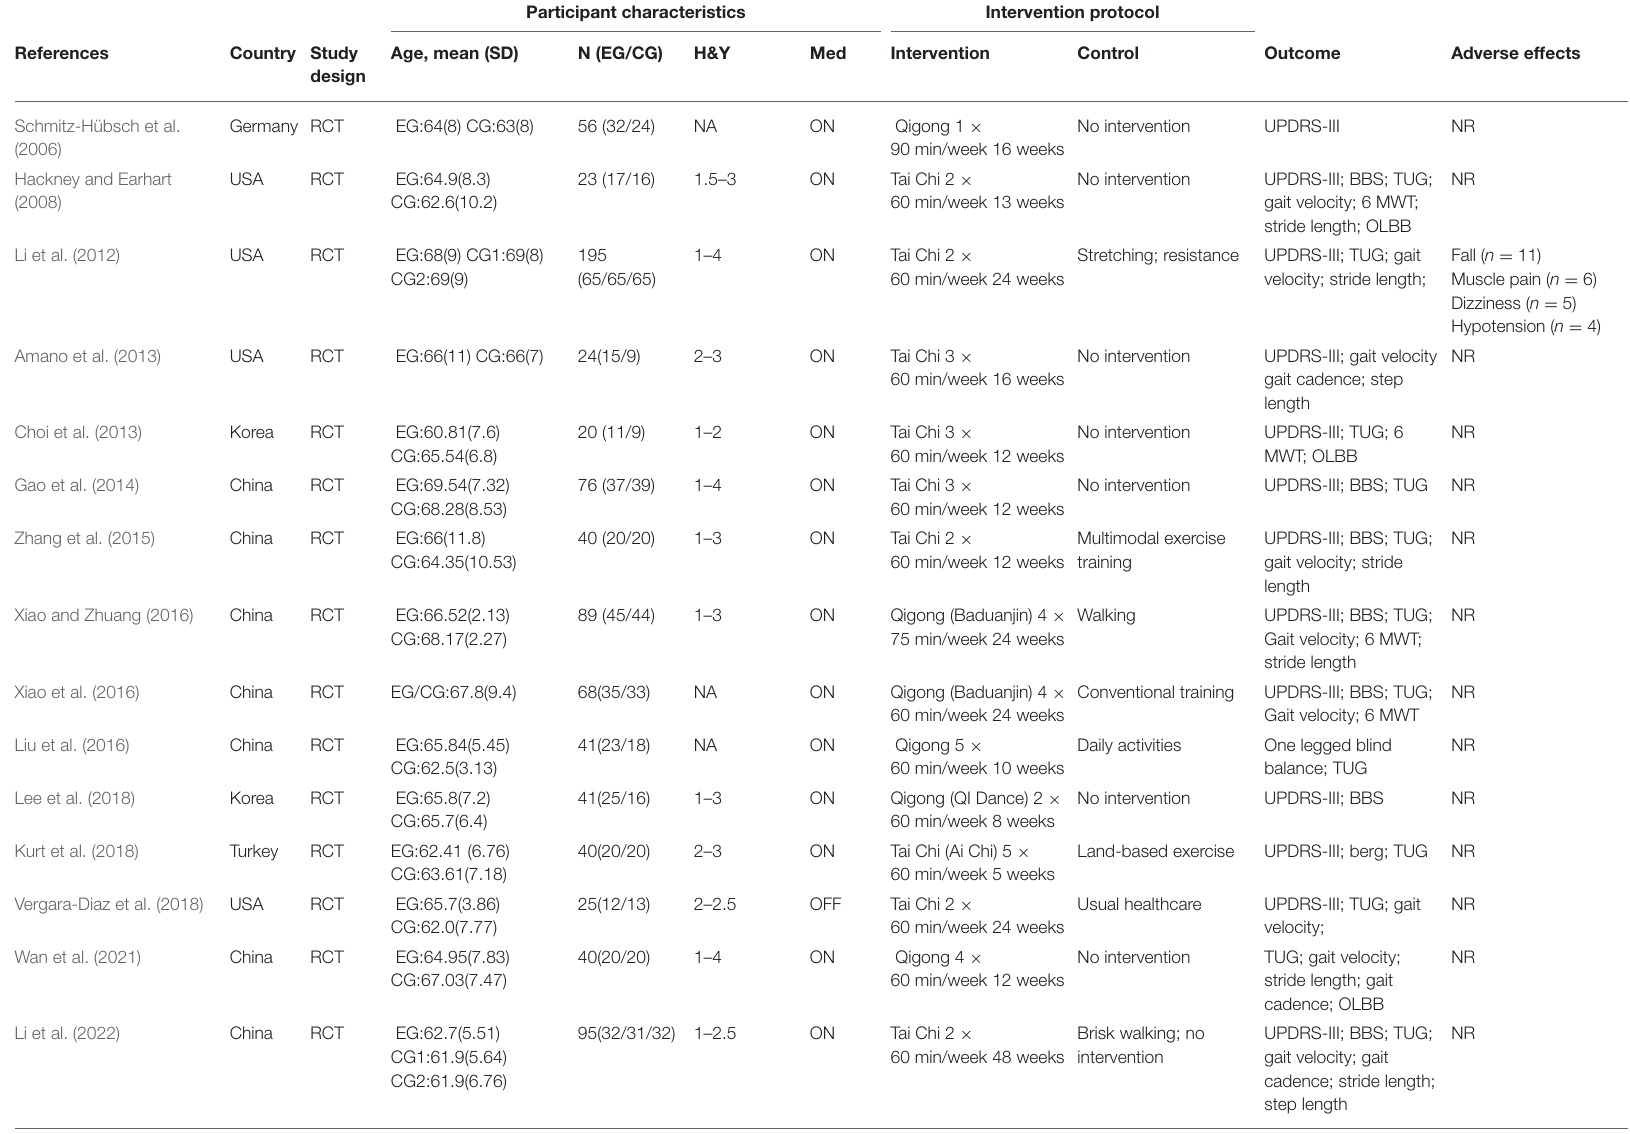
TABLE 1 | Characteristics of randomized controlled trials included in the